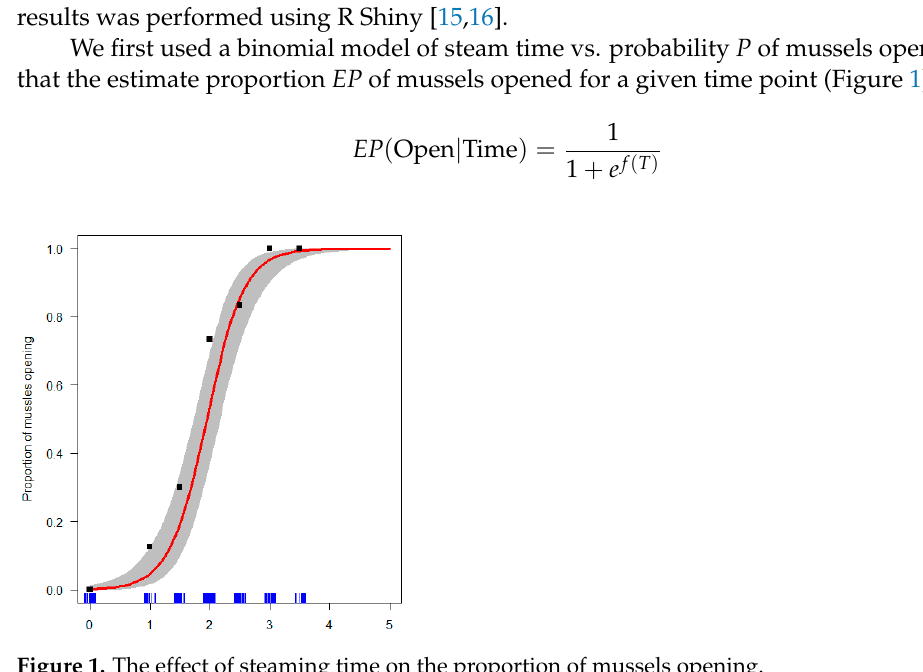
Figure 1. The effect of steaming time on the proportion of mussels opening. Data were treated to account for “worst case scenarios”, so when E. coli were not detected by enumeration (i.e quantitative analysis with detection level 10 cfu/g), but only after enrichment, E. coli numbers were set to 9 cfu/g.